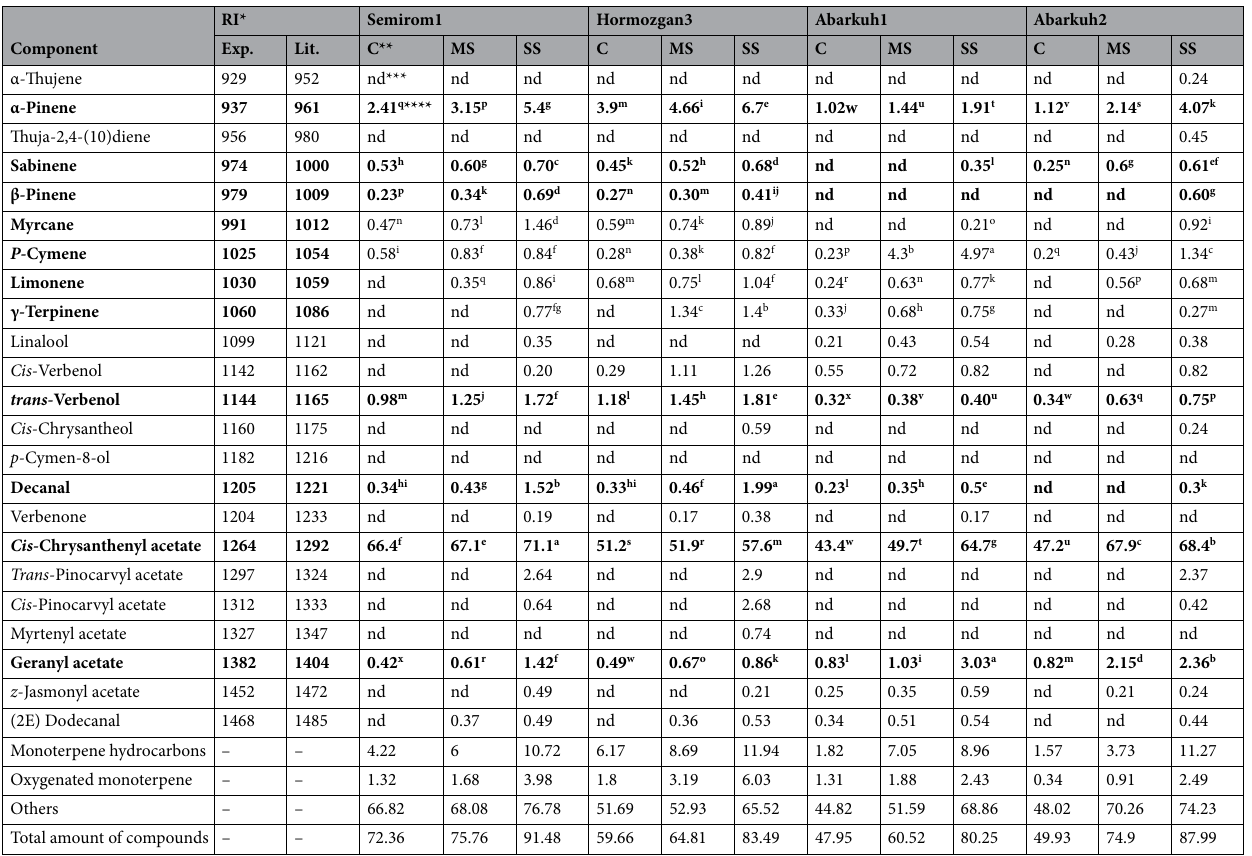
Table 3. The mean of essential oil composition of eight Moshgak populations evalutated at three levels of irrigation. Significant values are in bold. *The data were sorted based on the retention index (RI) of components. **C: Control; MS: Moderate Stress; SS: Severe Stress. ***nd: Not detected. Literature indexes were obtained from NIST database (2009). ****The means were significantly different at 5% probability level. Mean with the different superscript letters in a column are different significantly (p <